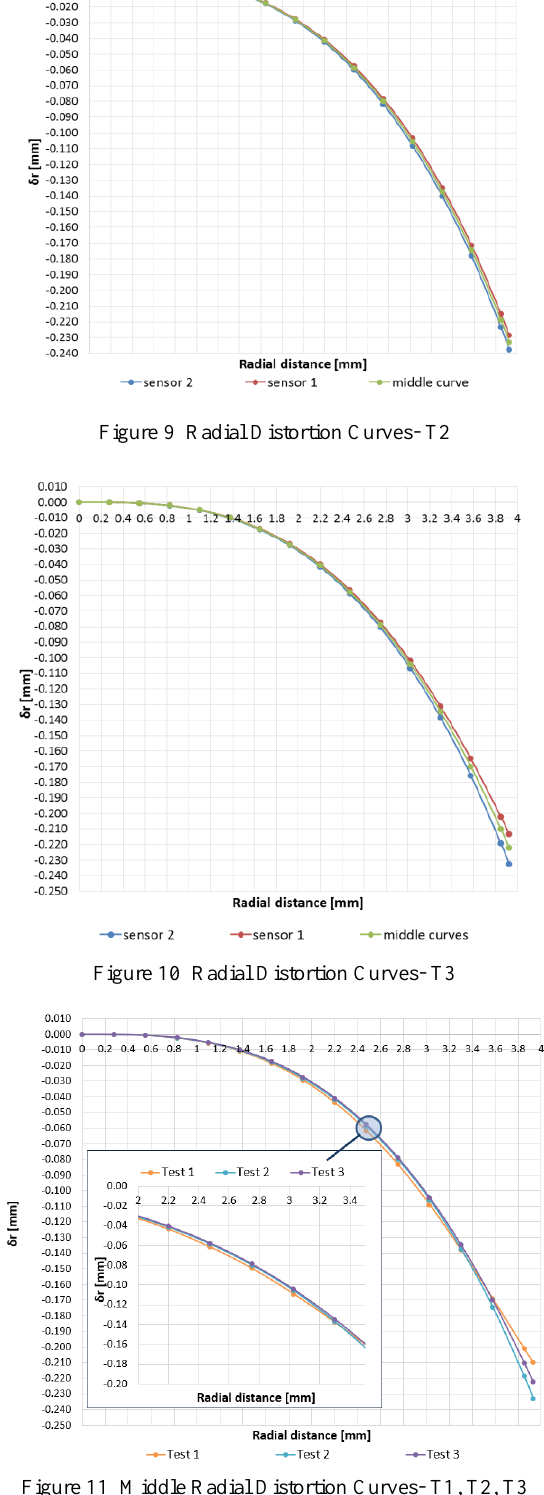
Figure 11 Middle Radial Distortion Curves- T1, T2, T3